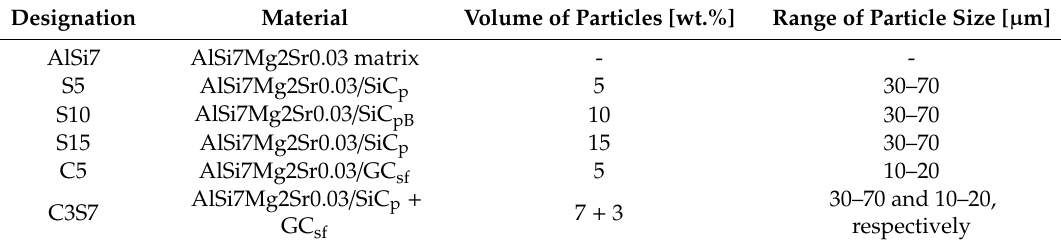
Table 2. Designation of samples used to determine tribological properties.